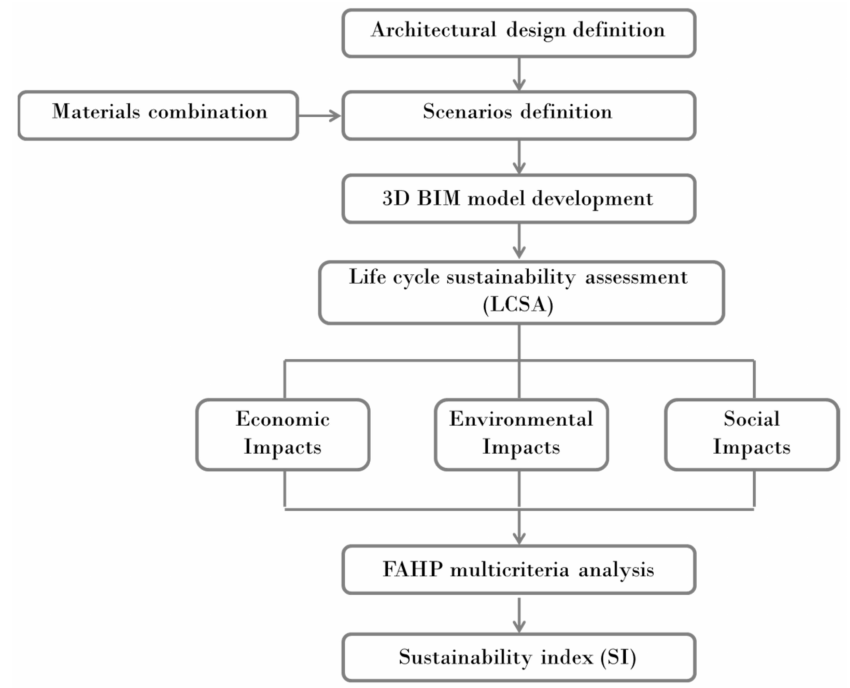
Figure 1. Flowchart describing the research